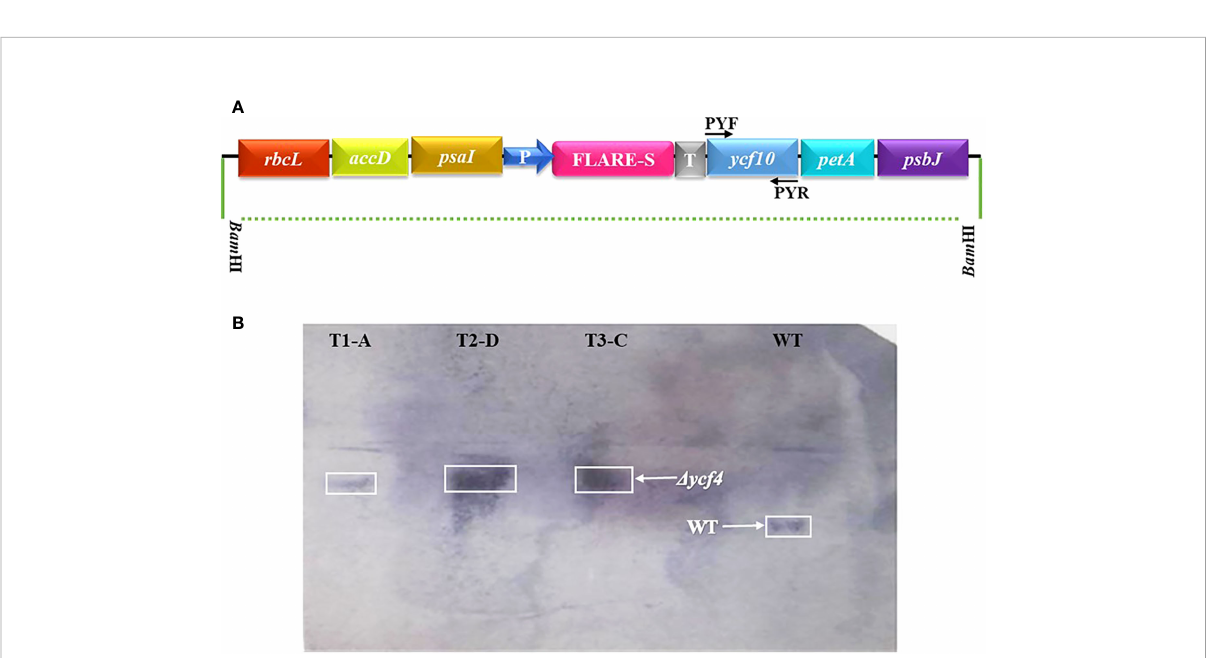
FIGURE 3 Con fi rmation of plasmy level of D ycf4 plants through Southern Blot Analysis. (A) Physical map showing location of primers used to amplify the probe. (B) Total cellular DNA of D ycf4 and wild-type tobacco plants was digested with Bam H1, transferred onto the nitrocellulose membrane, and hybridized against a biotin-labeled probe prepared from ycf10 that ampli fi es both transformed and wild-type chloroplast DNA since ycf10 gene-speci fi c probe detects all plastome copies irrespective to their genotype whether transformed or wild-type (untransformed). However, these plants were selected from an already screened pool (T1-T4 as shown in Figure 2C) of transgenic